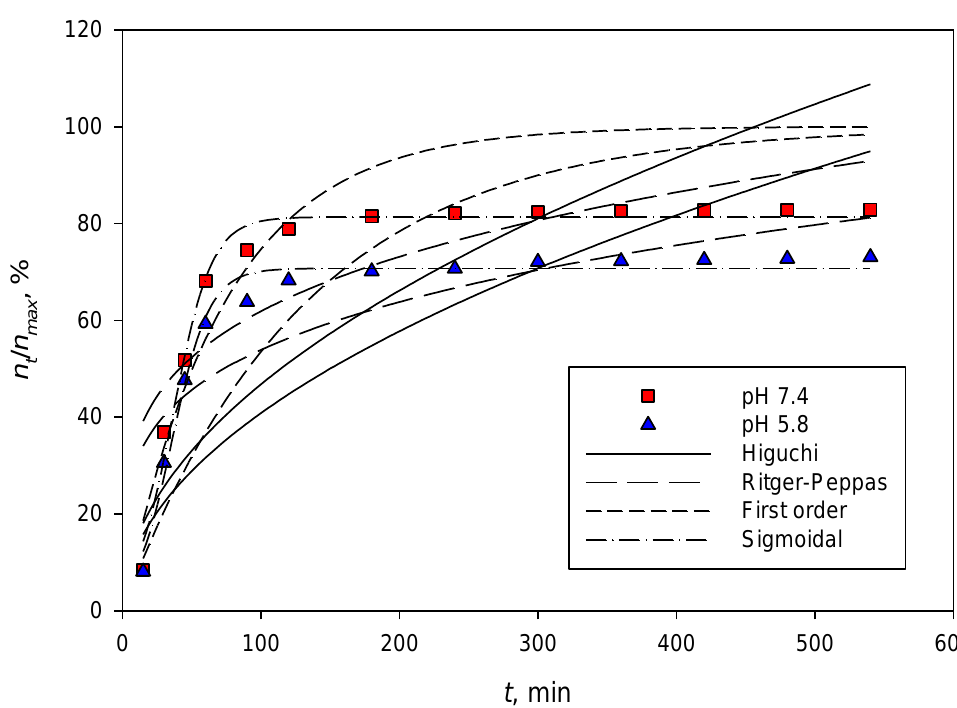
Figure 6. Dexamethasone released from CNCs-rarasaponin at 37 °C.